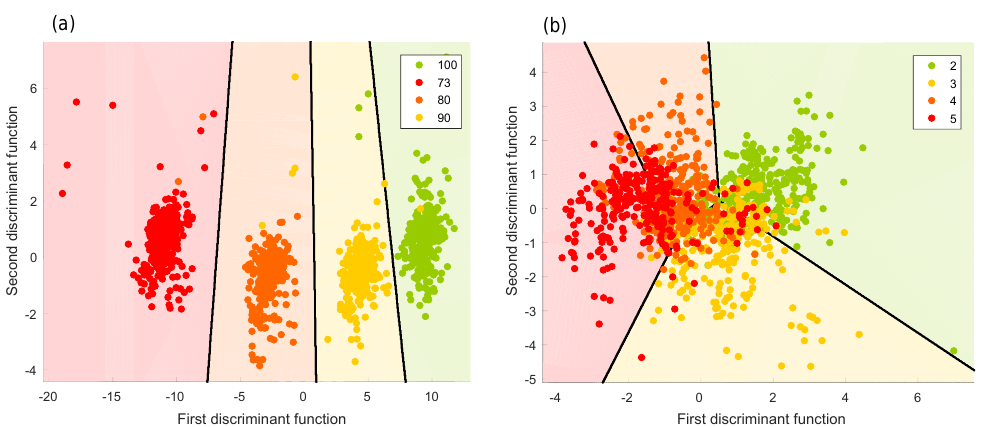
Figure 14. Territorial plots of the discrimination of fault severity for (a) a valve and (b) a hydraulic accumulator.